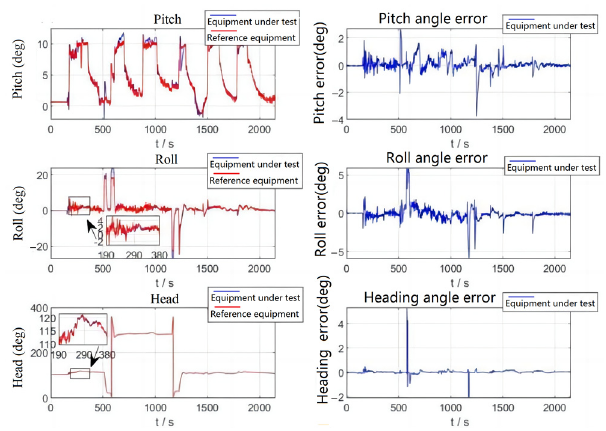
Figure 8. Flight test attitude comparison and attitude error.